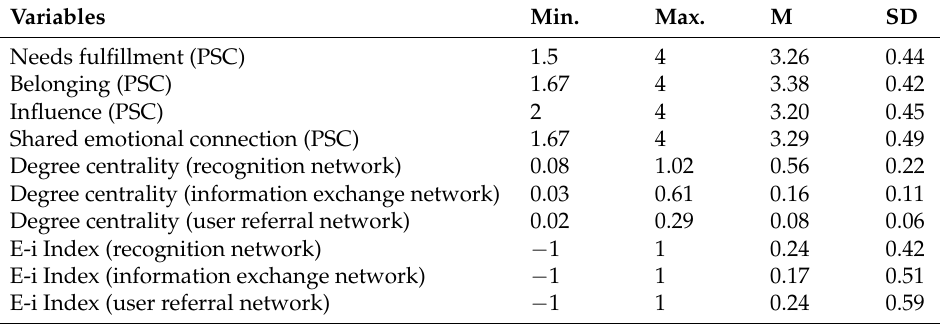
Table 1. Descriptive statistics of the variables analyzed ( N =